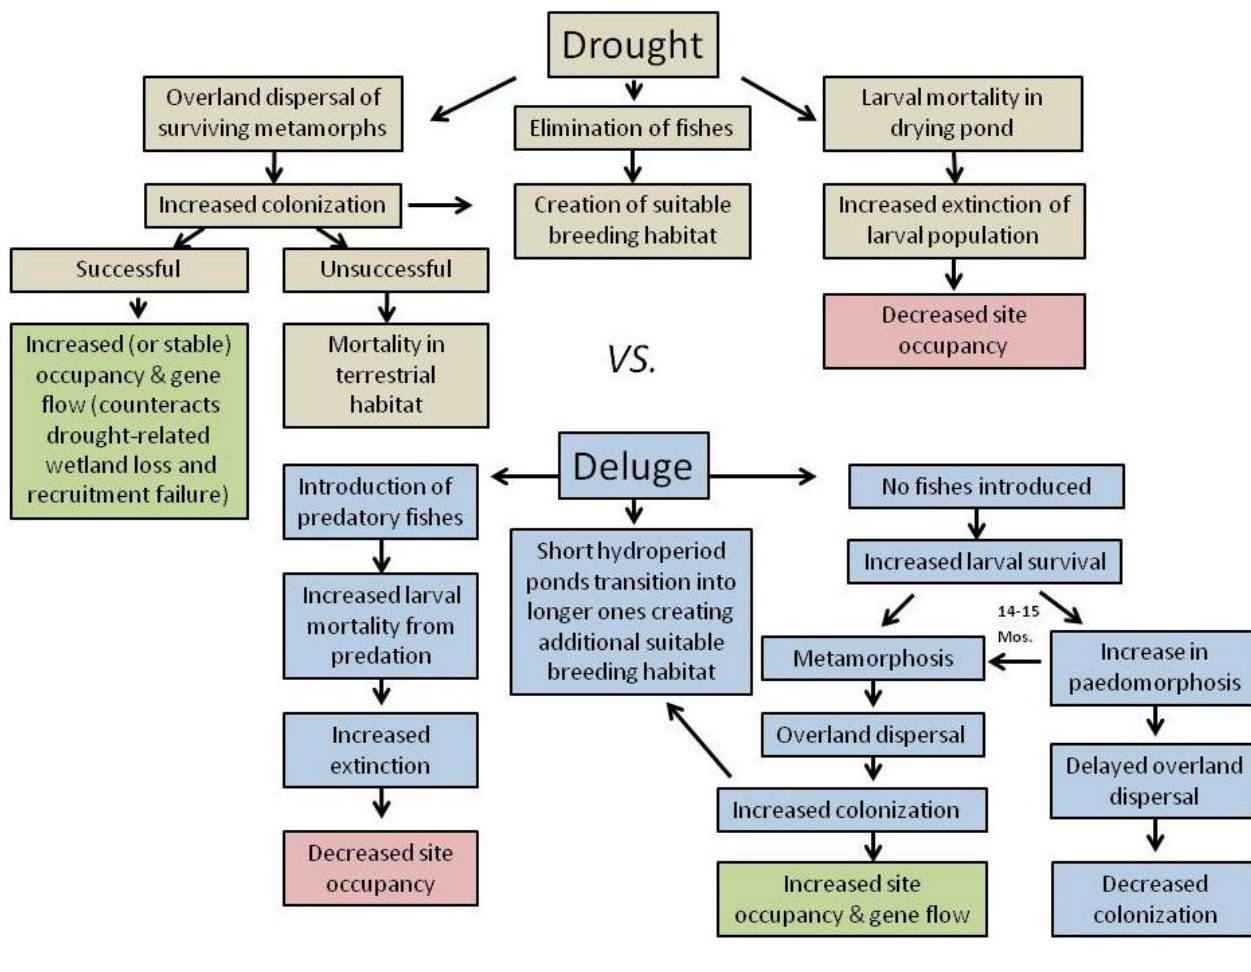
Figure 2. Hypothesized landscape and metapopulation-level consequences of alternative climate change scenarios (drought versus deluge) for the Mole Salamander, Ambystoma talpoideum . Consequences of decreased precipitation are shown in tan and those from increased precipitation are shown in blue. In both scenarios, site occupancy may either increase (in green) or decrease (in